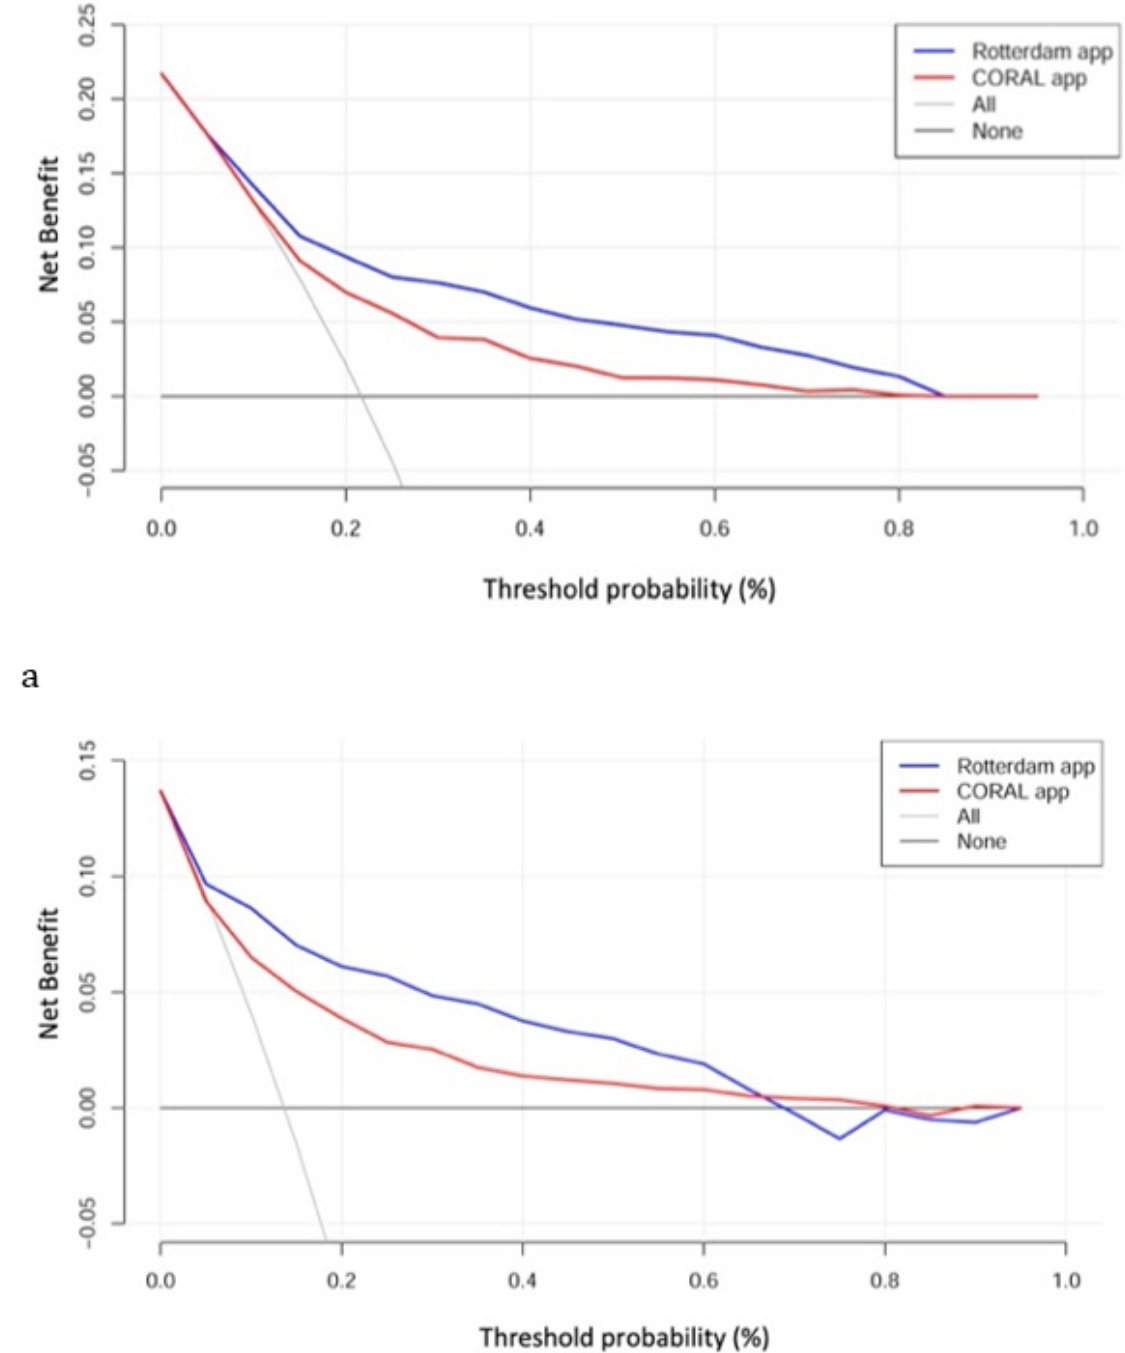
Figure 4. Decision curve analyses quantifying clinical utility by showing the net benefits associated with the use of the Rotterdam app (blue line) and the Coral app (red line) in (a) the detection of prostate cancer (PCa) and (b) high-grade PCa. Decision curves investigate the theoretical net benefit at various threshold probabilities. The oblique gray line assumes that all persons will undergo prostate biopsy, whereas the horizontal black line along the x-axis assumes that no one will receive biopsy. The threshold probability may correspond to the calculated prostate cancer risk. The area under the curve between these 2 lines illustrates net benefits. In the same range of threshold probability, higher net benefits represent better clinical